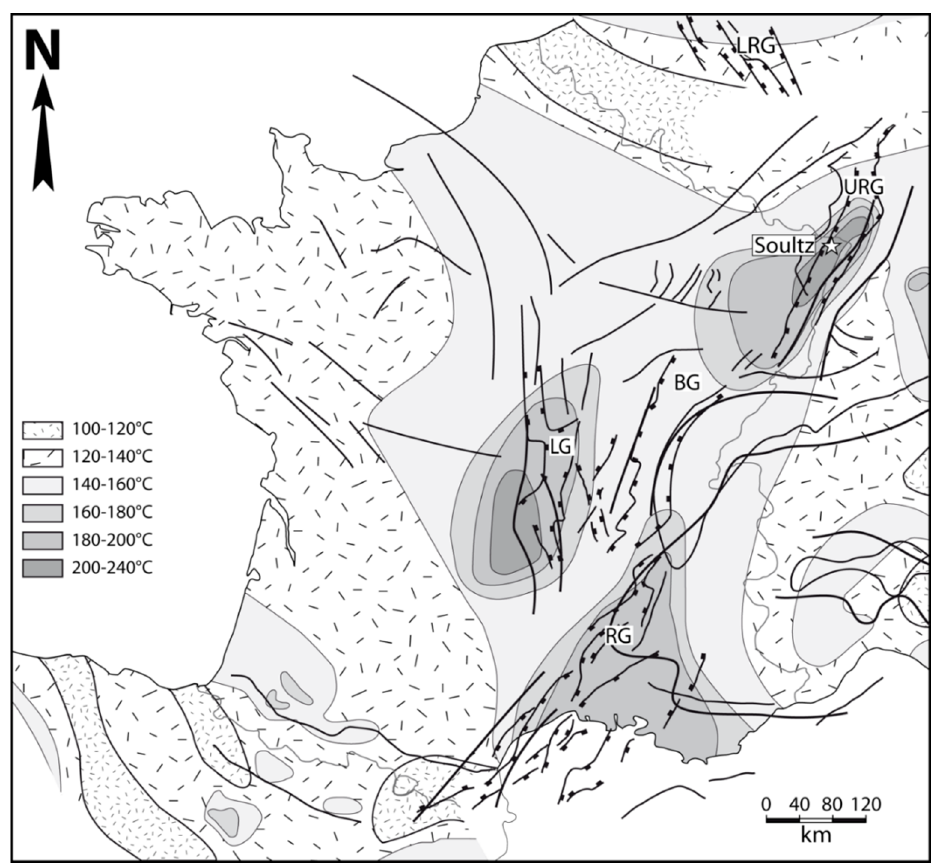
Figure 11. Thermal anomalies in France at 5km depth. From north to south: LRG: Lower Rhine Graben, URG: Upper Rhine Graben, BG: Bresse Graben, LG: Limagne Graben, RG: Rhône Graben. Modified after [80].